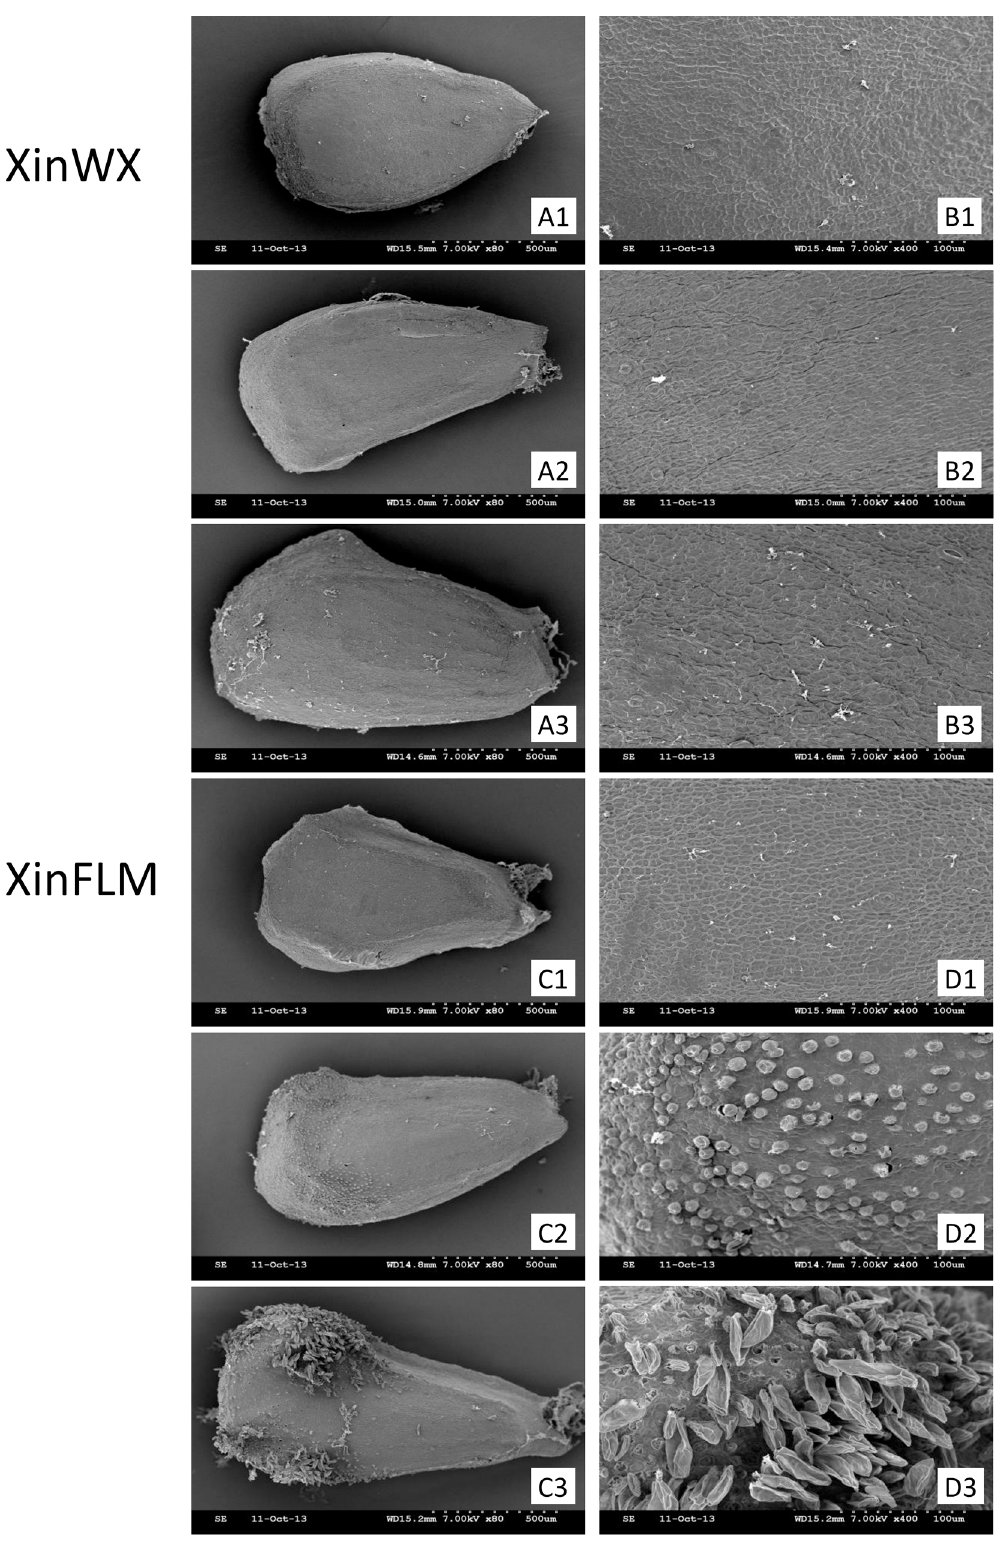
Fig 1. Scanning electron micrographs of ovules at -1, 0 and 1DPA in XinWX and XinFLM. (A, B) ovules of XinWX. (C, D) ovules of XinFLM. 1 – 3 indicate the day before anthesis (-1 DPA), the day of the anthesis (0 DPA), and the day after anthesis (1 DPA), respectively. Working distance (WD), accelerating voltage (7.00KV) and magnification (left: 50×; right: 400×) are indicated. doi:10.1371/journal.pone.0129854.g001 PLOS ONE | DOI:10.1371/journal.pone.0129854 June 16,